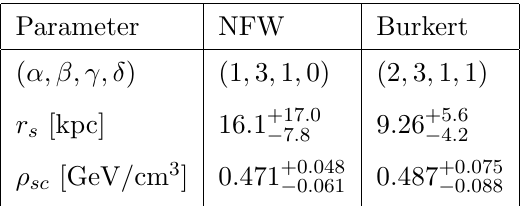
Table 1. Parameters for the NFW and the Burkert DM density pro(cid:12)les [56].